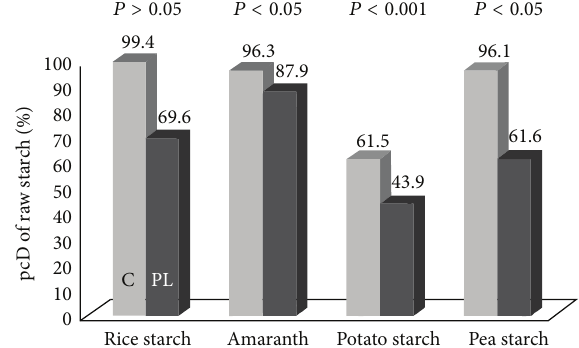
Figure 1: pcD of different sources of starch fed raw to control-pigs (C, light grey bars) and pancreatic duct ligated pigs (PL, grey bars).